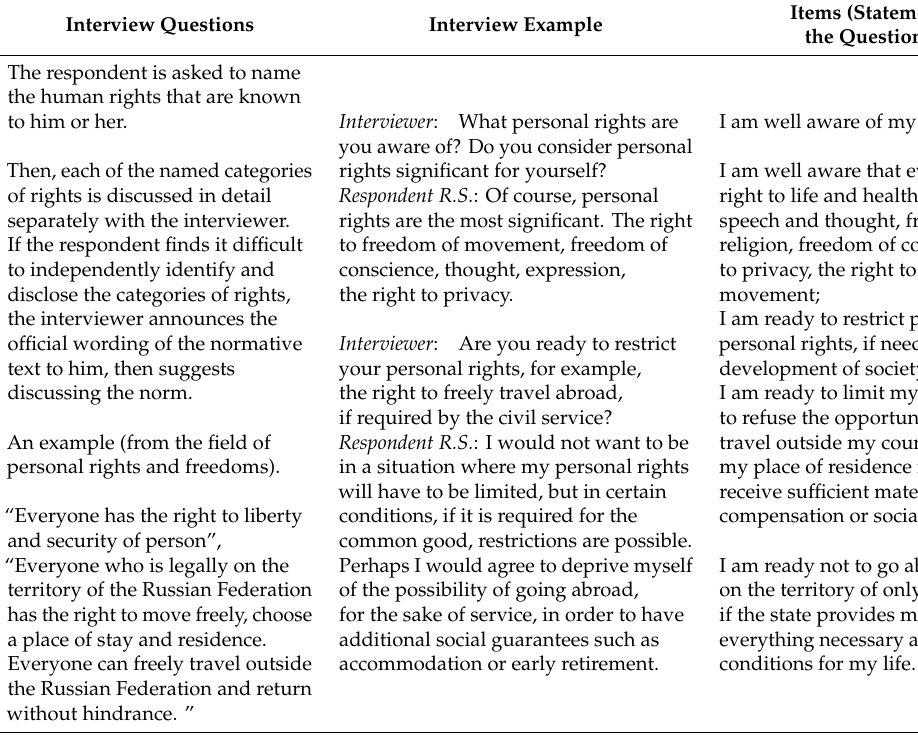
Table 2. An example of an algorithm of designing of the questionnaire